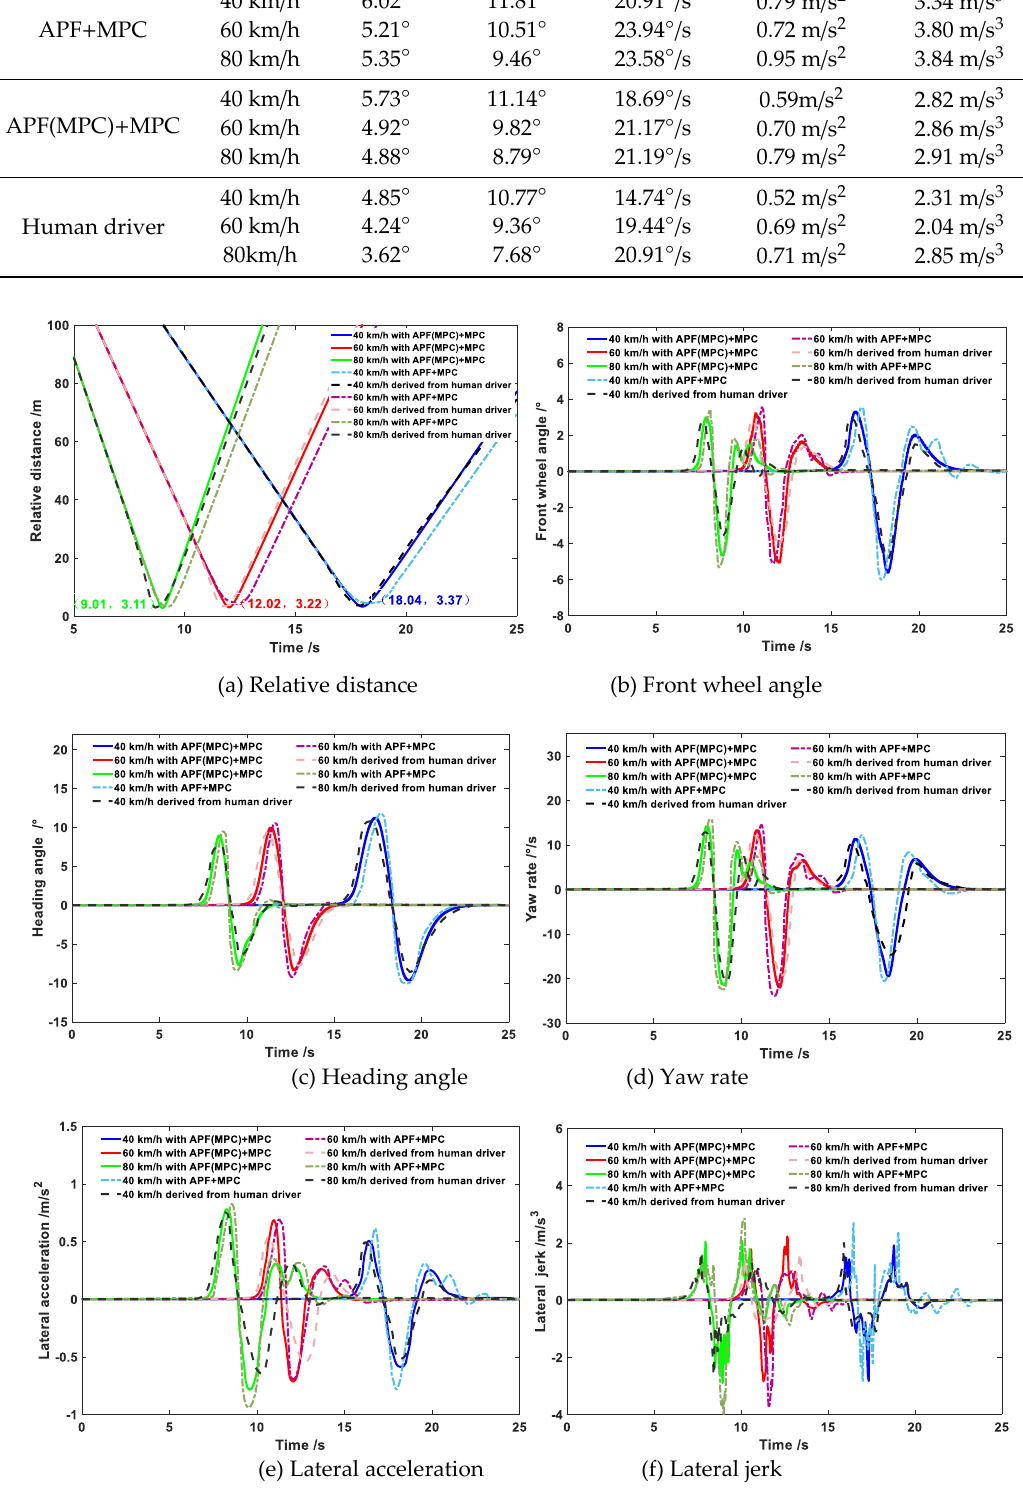
Figure 18. Co-simulation results of vehicle states during the obstacle avoidance process under different speeds. di ff erent